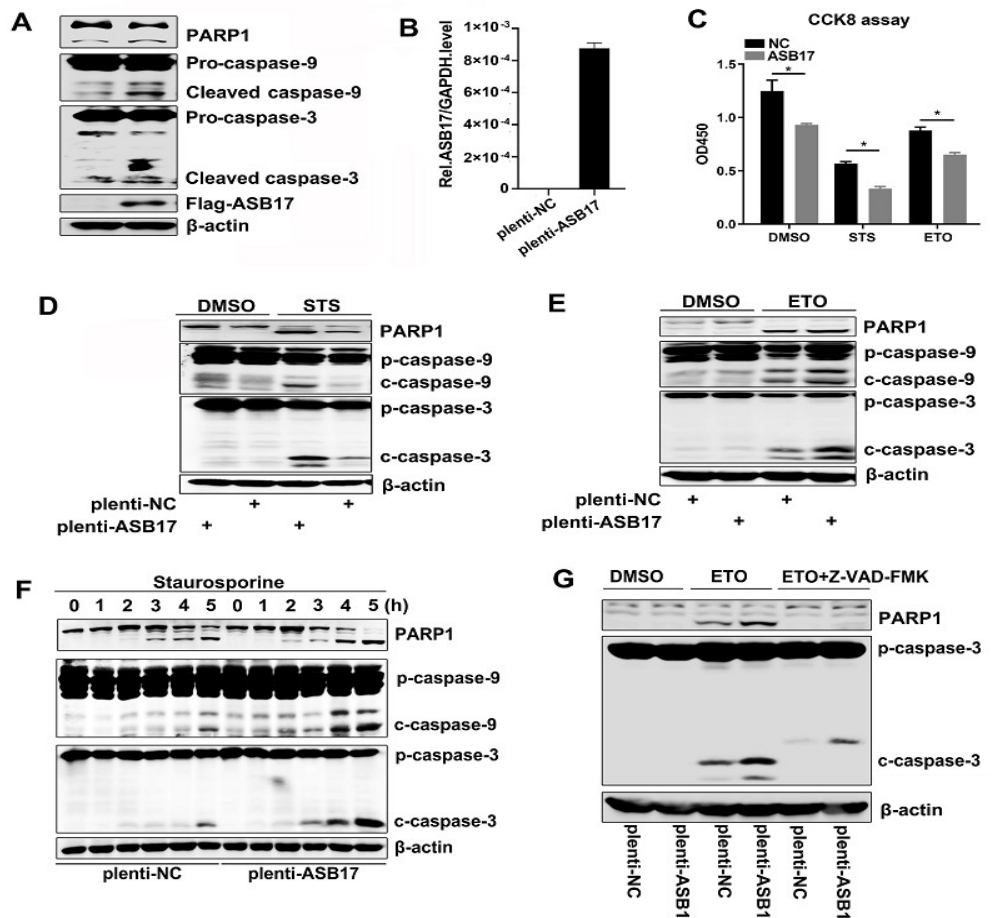
Figure 5. ASB17 promotes apoptosis in vitro. ( A ) Immunoblot analysis of extracts from Hela cells transfected with control plasmid or Flag-ASB17. The cell lysates were immunoblotted with the indicated antibodies. ( B ) Q-PCR analysis of mRNA of ASB17 of control and ASB17 stably expressed Hela cells. ( C ) CCK8 assay of control and ASB17 stably expressed Hela cells treated by DMSO, staurosporine (STS) (1 µ M) for 4 h, and etoposide (ETO) (1 µ g/mL) for 24 h. ( D , E ) The control and ASB17 stably expressed Hela cells were treated with DMSO and STS ( D ) for 4 h or ETO ( E ) for 24 h. Cell lysates were immunoblotted with the indicated antibodies. ( F ) Immunoblot analysis of extracts from control and ASB17 stably expressed Hela cells treated with STS in the indicated time. ( G ) Immunoblot analysis of extracts from control and ASB17 stably expressed Hela cells treated with DMSO, ETO, or ETO and Z-VAD-FMK for 24 h. *, p <